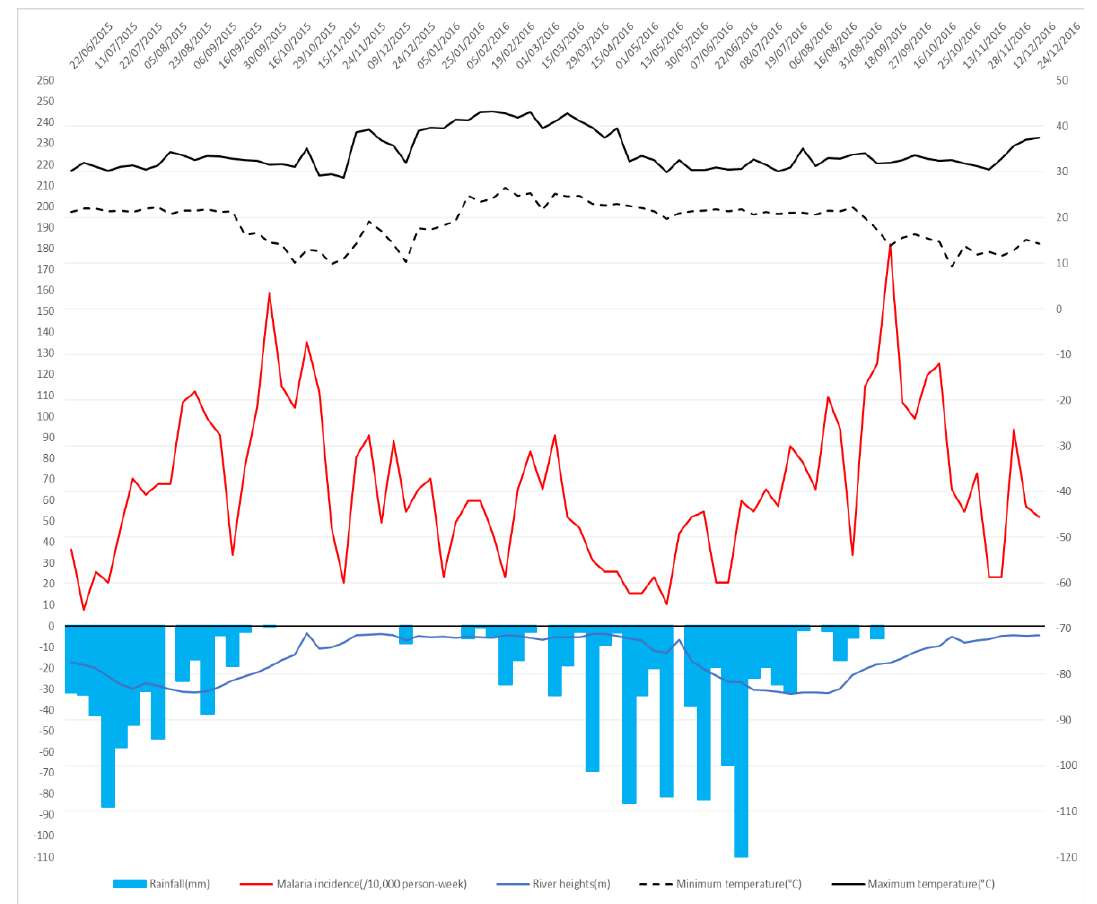
Figure 2. Time series patterns for the Dangassa study site. Malaria incidence time series, maximum temperature, minimum temperature, rainfalls and river height by week. The red line represents weekly malaria incidences, the dashed and solid black lines represent respectively the weekly mean of minimum and maximum air temperature, the solid blue line represents the weekly mean of river height and the blue bar plot represents the weekly cumulative rainfall .